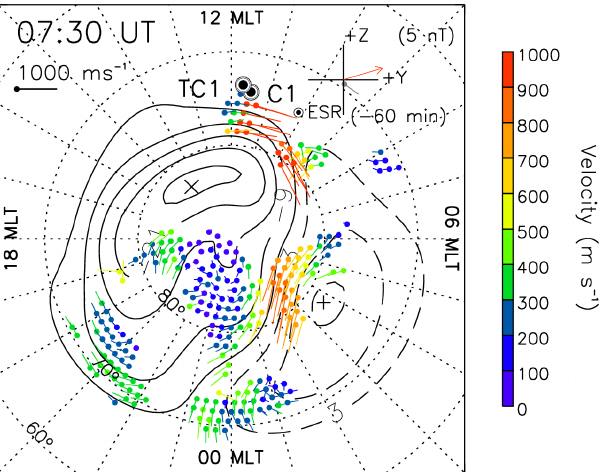
Fig. 4. SuperDARN northern hemisphere ionospheric convection pattern at 07:30 UT on 25 March 2004, derived using the technique of Ruohoniemi and Baker (1998). The location of the ESR and the magnetic footprints of the Cluster 1 and TC-1 spacecraft are also